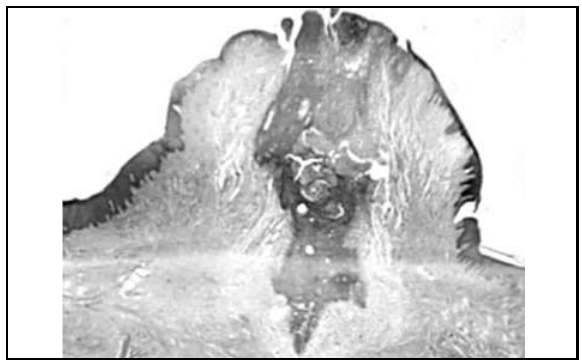
Figure 2 – Low-power photomicrograph in H&E of the ECOC (x 100)